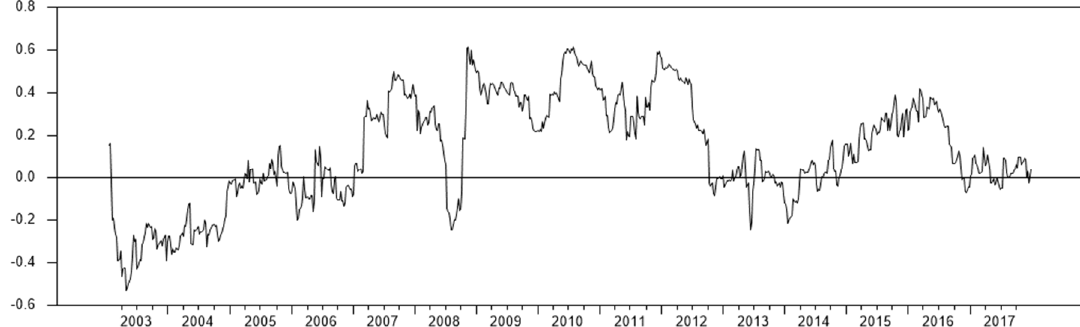
Figure 3. Dynamic correlation between the South African equity market and the yen-funded carry trade returns.